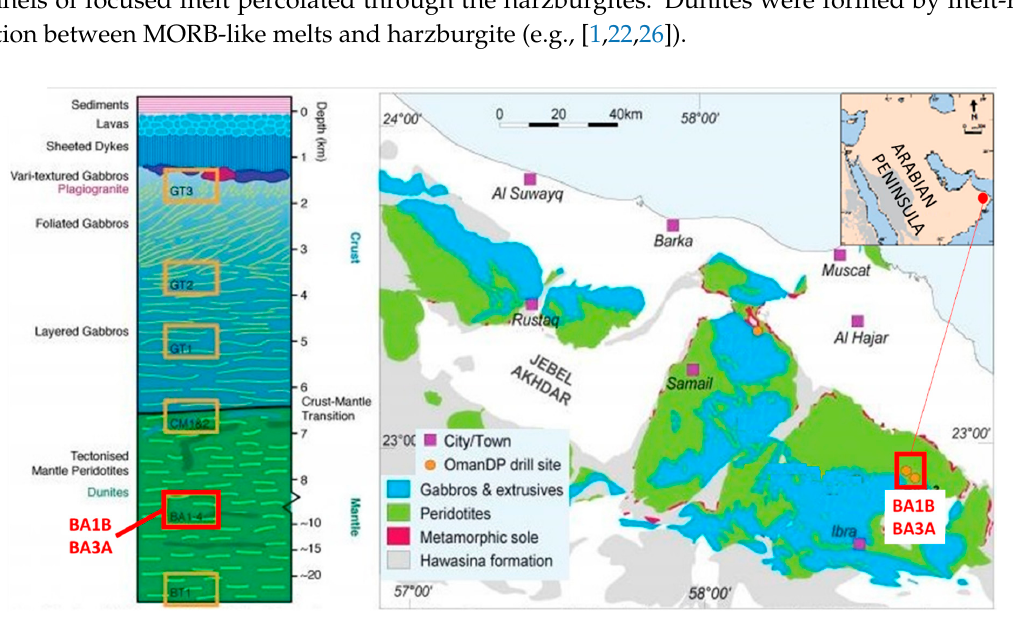
Figure 1. Geological map of Wadi Tayin massif of the Semail ophiolite showing the OmanDP drill site locations and their relative stratigraphic positions in a reconstructed stratigraphic log (modified from [27]). The red box indicates the area of BA1B and BA3A drill sites.